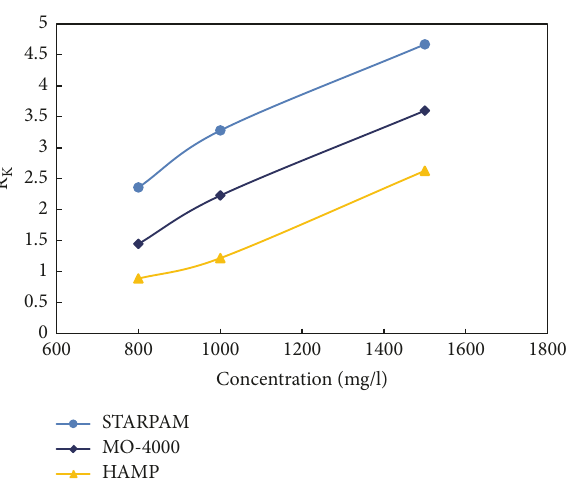
Figure 10: Residual resistance coefficient of three